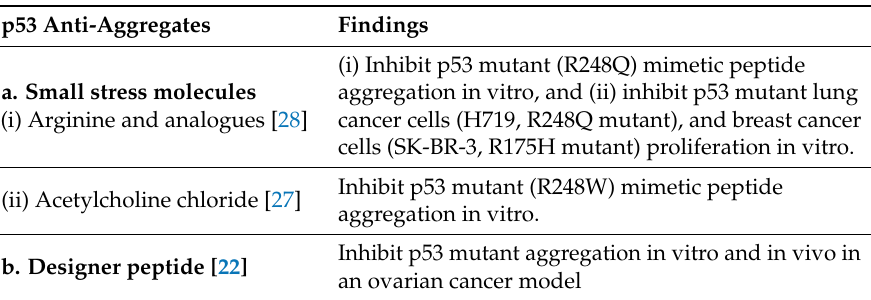
Table 1. Summary of recent studies on p53 Anti-Aggregate drugs.